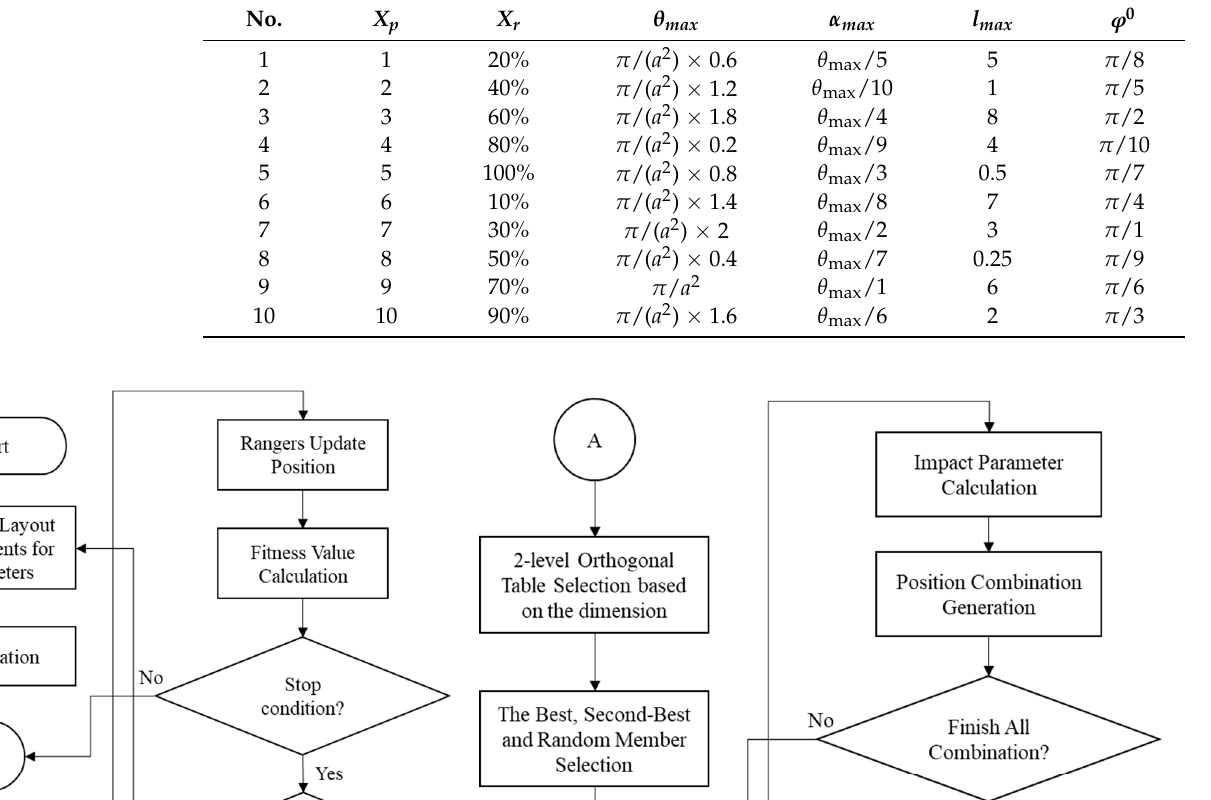
Table 10. The U 10 (10 6 ) uniform layout with the tunable factors of R-GSO.